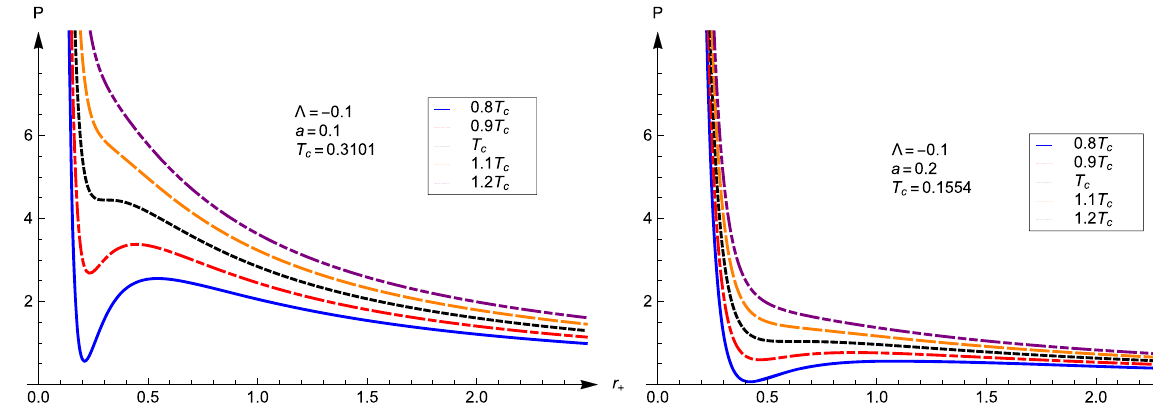
Fig. 5 Pressure versus r + for (cid:2) = − 0 . 1 and a = 0 . 1 (left panel), and a = 0 . 2 (right panel)